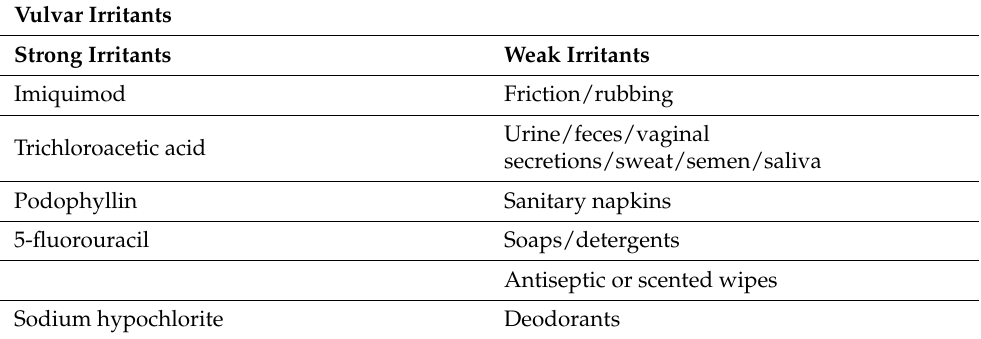
Table 1. List of the most common irritants responsible for vulvar